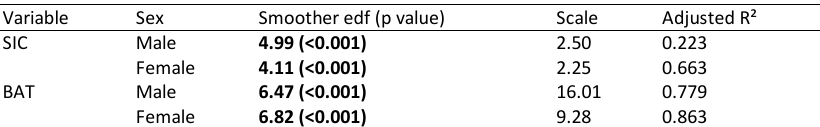
Table 5. Generalized Additive Model (GAM) results for foraging intensity of male and female snow petrels as a function of sea ice concentration (SIC) and bathymetry (BAT). edf indicates the estimated